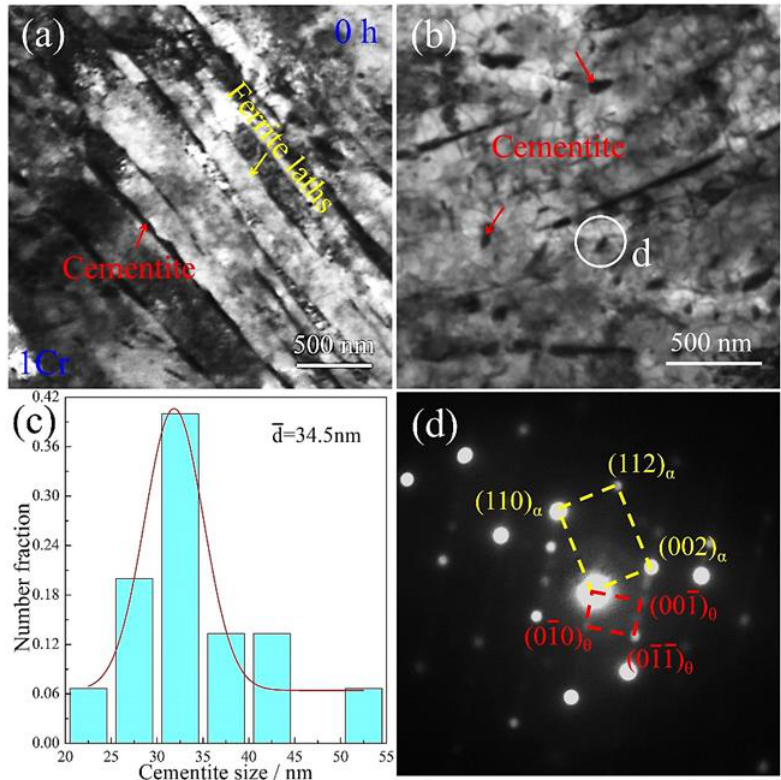
Figure 5. TEM images of the 1Cr creep-free samples: ( a ) BF image showing ferrite laths and cementite along the ferrite lath boundaries; ( b ) BF image showing cementite in ferrite lath interiors; ( c ) statistical size distribution of cementite particles; ( d ) SAED pattern taken from the circle in ( b ) under the [11̅0] 𝛼 zone axis.